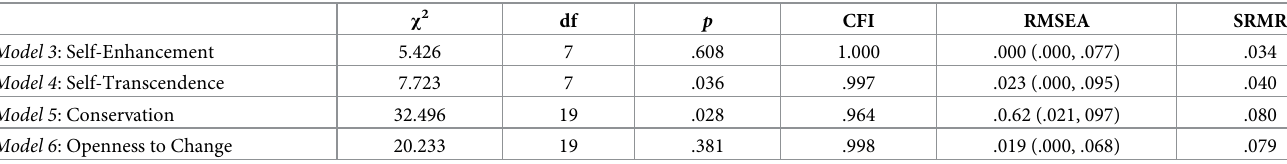
Table 4. Goodness of fit indices of univariate conditional LCS models.